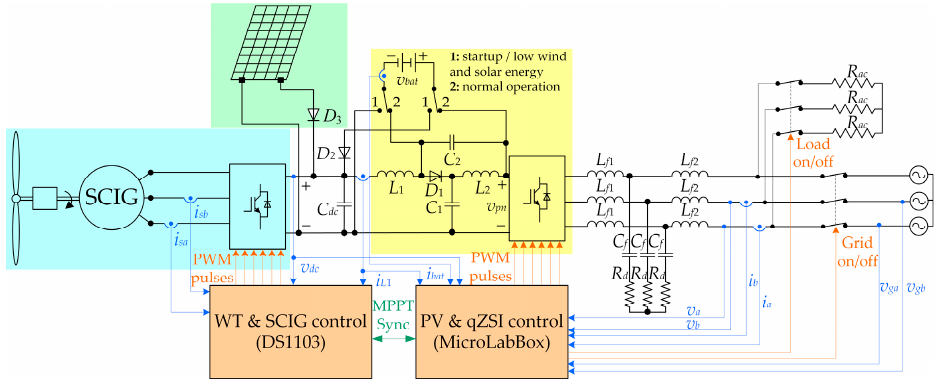
Figure 1. Configuration of the proposed qZSI-based wind–solar system.